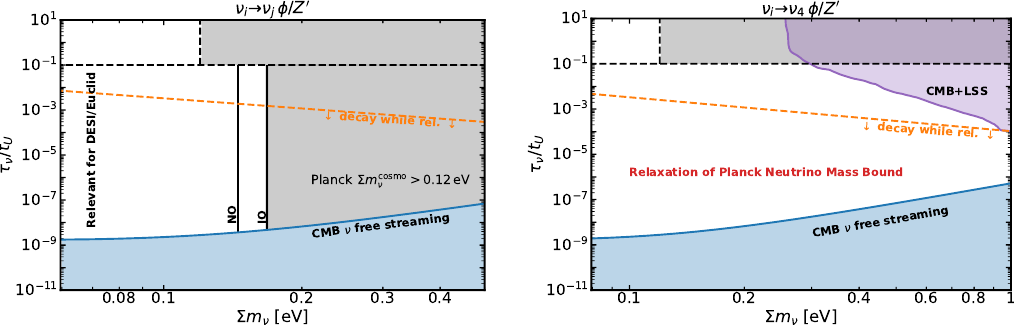
Figure 3 . Constraints on invisible neutrino decays. The blue regions are excluded by Planck legacy observations analyzed in the relativistically decaying neutrino framework [22]. The magenta region is excluded by the analysis of late time matter clustering and CMB lensing from [21]. In orange we show the line separating relativistically and non-relativistically neutrino decays given by [21]: √ 1 /τ ν ’ H 0 Ω m ( P m ν / (9 T ν, 0 )) 3 / 2 . Left panel: bounds on decays of the type ν i → ν j φ/Z 0 with m φ,Z 0 = 0 . Right panel: . bounds on decays of the type ν i → ν 4 φ/Z 0 with m ν same bounds apply to ν i → ν 4 ¯ ν 4 ν 4 decays). Note that the impact of ν i → ν j φ/Z 0 in late time cosmological observables has not yet been studied in the literature. Such study may yield additional constraints. Therefore, the region of parameter space excluded by the Planck bound on P m cosmo (see figure 4) shown in the left panel constitutes an estimated